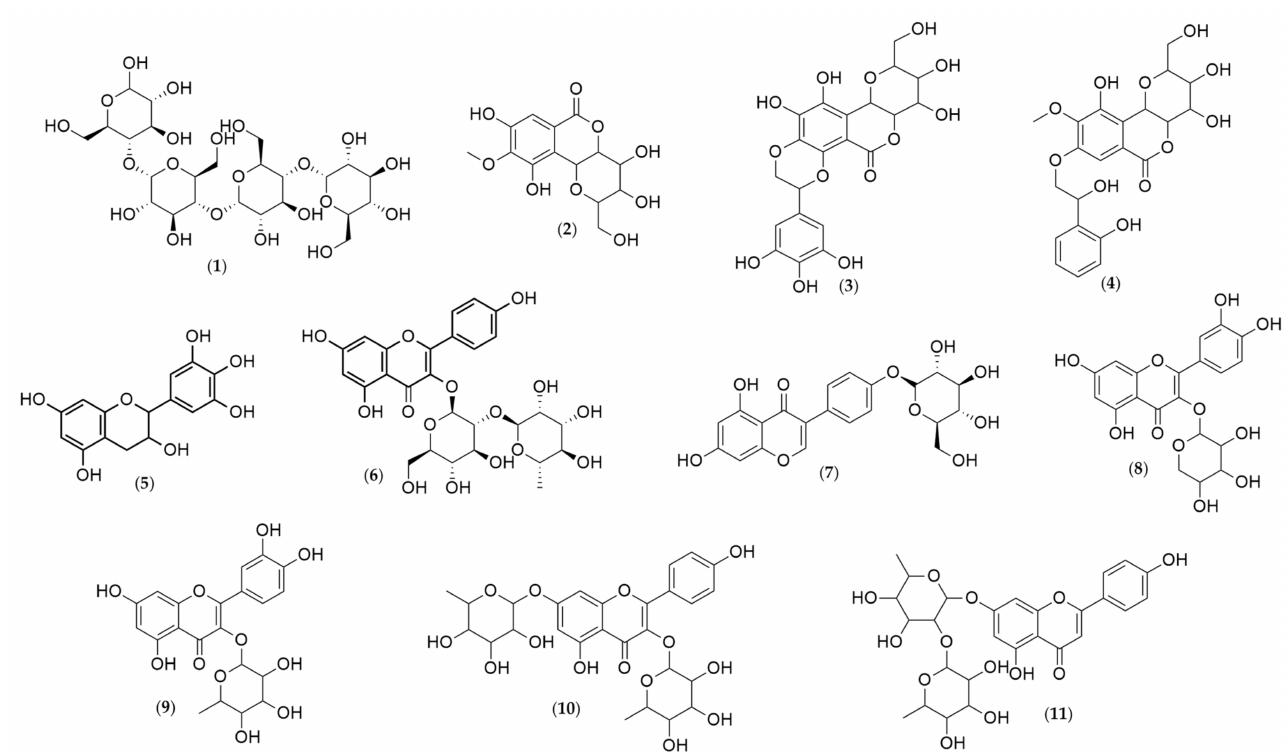
Figure 3. Chemical structures of the substances identified in the extracts of Humiria balsamifera (Aubl) by HPLC-ESI- IT/MS using the MassBank Spectral DataBase. Maltotetraose ( 1 ); Bergenin ( 2 ); Galloylbergenin ( 3 ); Hydroxybenzoyl bergenin ( 4 ); Gallocatechin ( 5 ); Kaempferol 3- O -neohesperidoside ( 6 ); Sophoricoside ( 7 ); Quercetin 3-arabinoside ( 8 ); Quercetin- O -rhamnoside ( 9 ); Kaempferol-dirhamnoside ( 10 ); and Vitexin-dirhamnoside ( 11